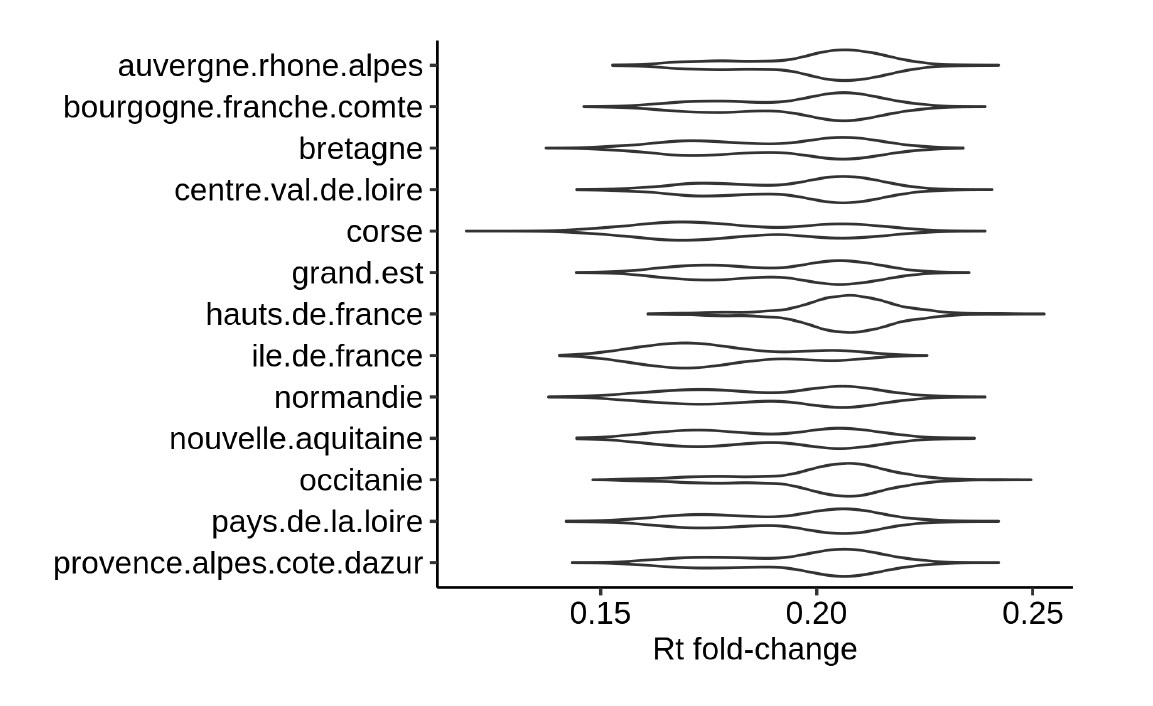
Figure 10 – Posterior distribution of R t fold change per